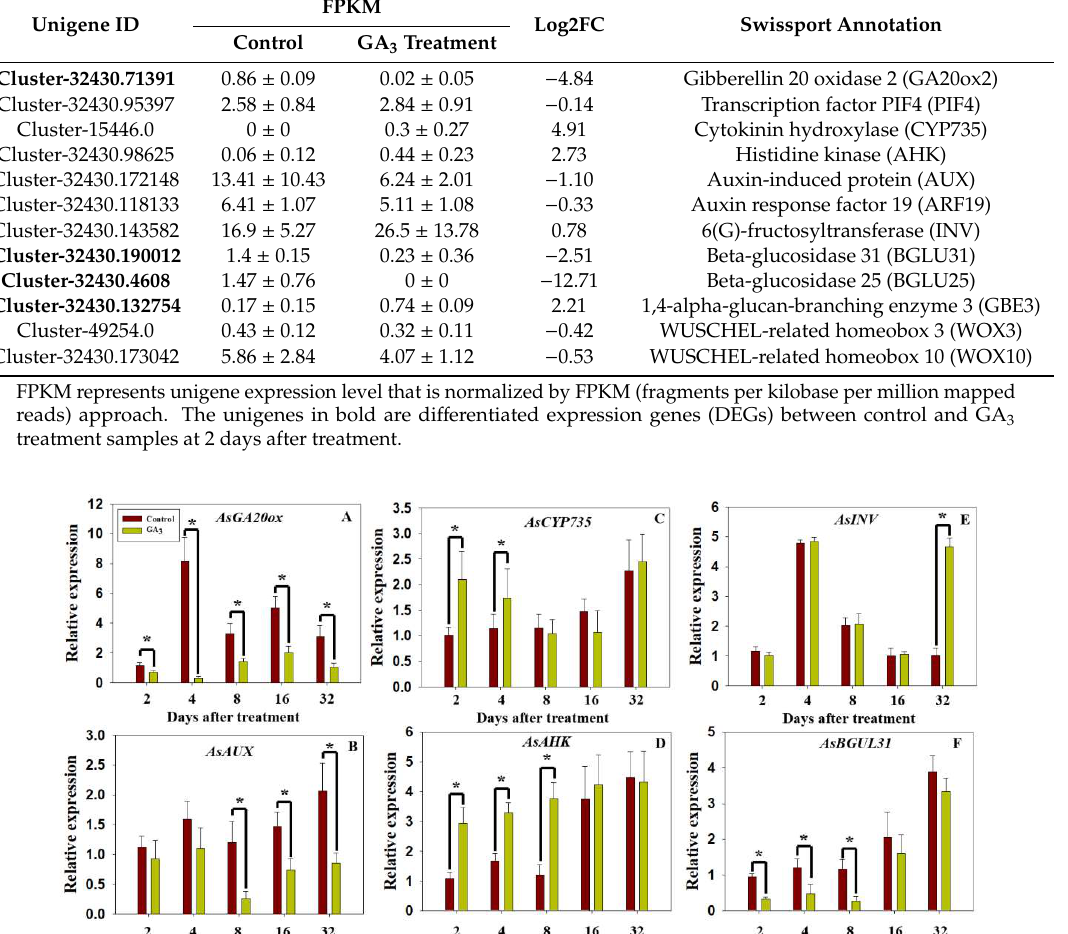
Table 2. Key unigenes (based on physiological analysis) in the GA 3 treatment and the corresponding unigenes in the control. FPKM Unigene ID Log2FC